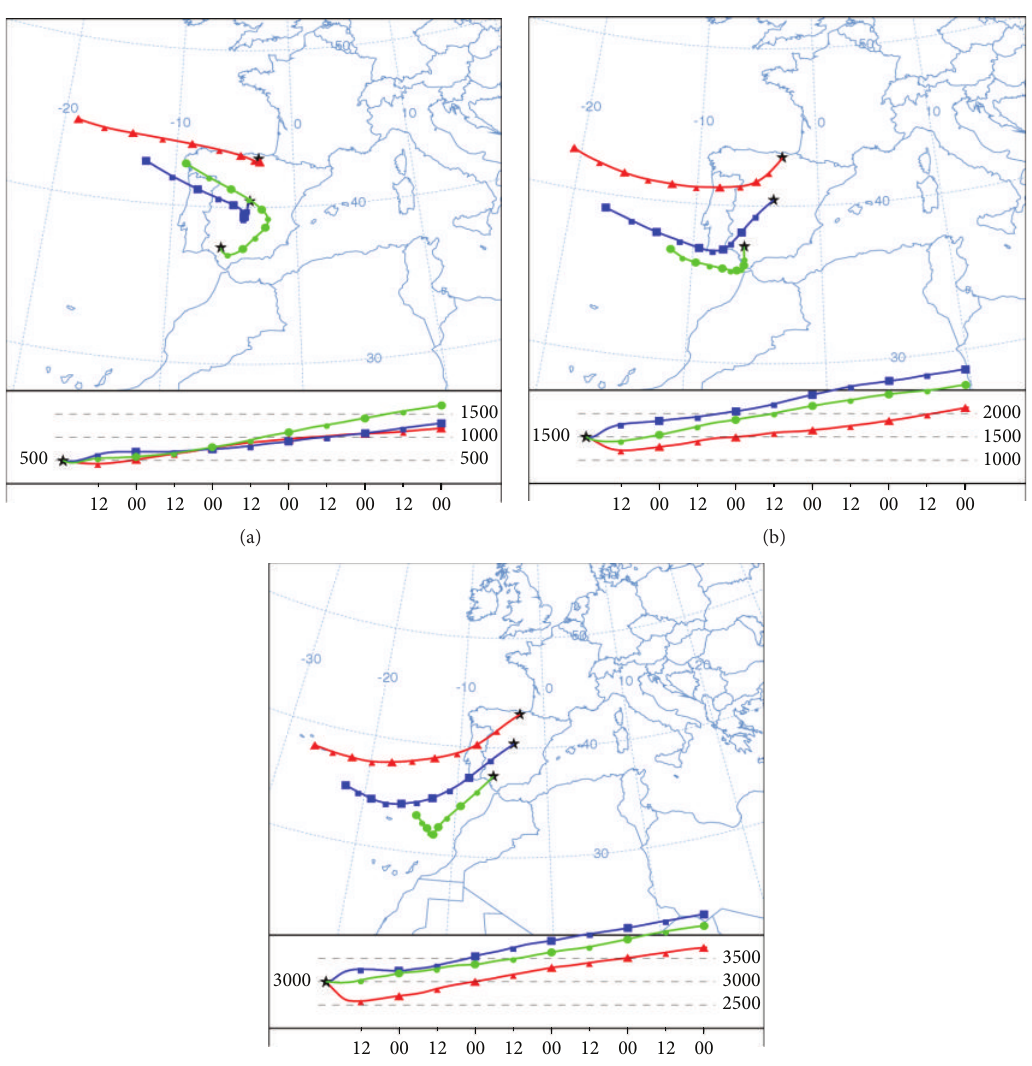
Figure 3: Mean trajectory (centroid) of the backward trajectories at Seville (green), Madrid (blue), and Bilbao (red) at (a) 500 m, (b) 1500 m, and (c) 3000 m during the whole set of identified heat-wave